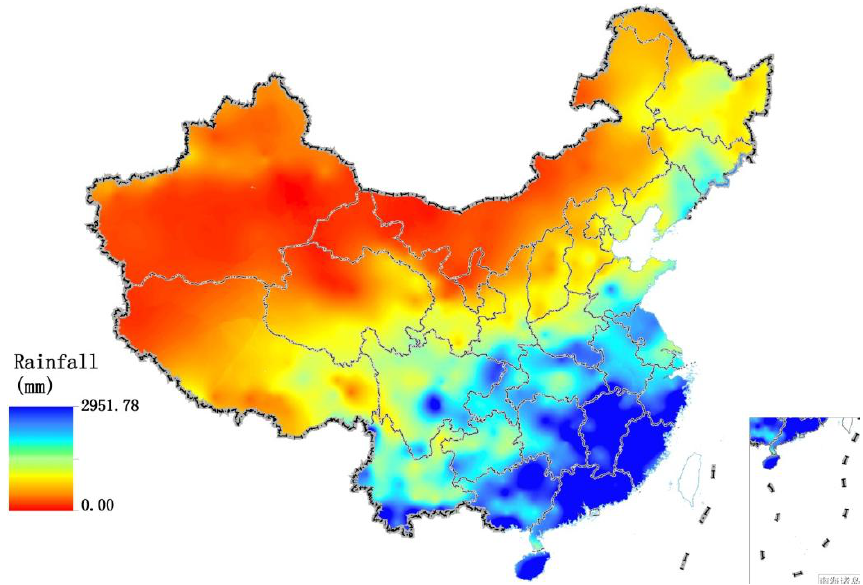
Figure 4. Spatial distribution of rainfall over China in 2005.